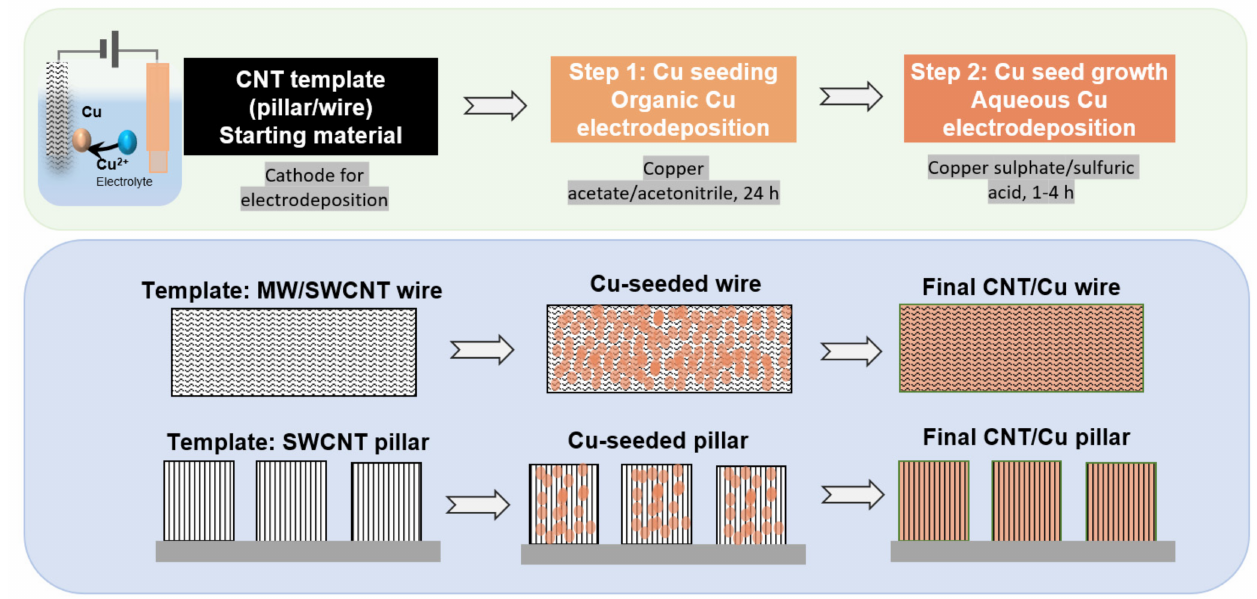
Figure 1. Schematic representing CNT/Cu fabrication by two-step Cu electrodeposition of CNT templates—wires and